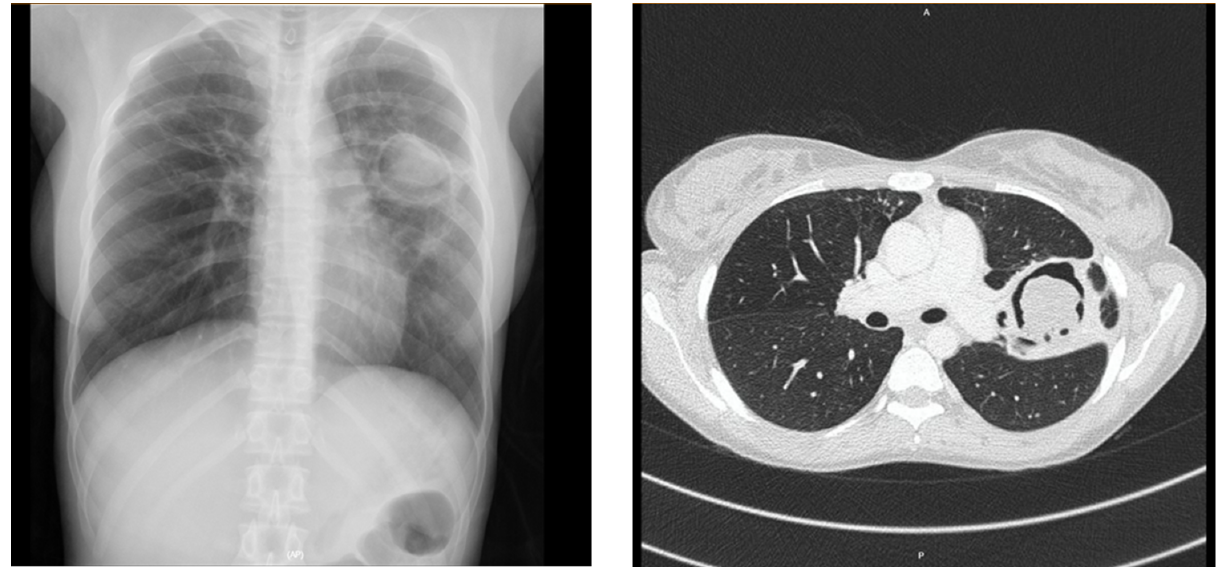
Figure 2. A 23 years old female patient with chest radiograph and CT thorax showing fungal ball in left upper lobe cavity. Her LDBio LFA and IgG were both negative.